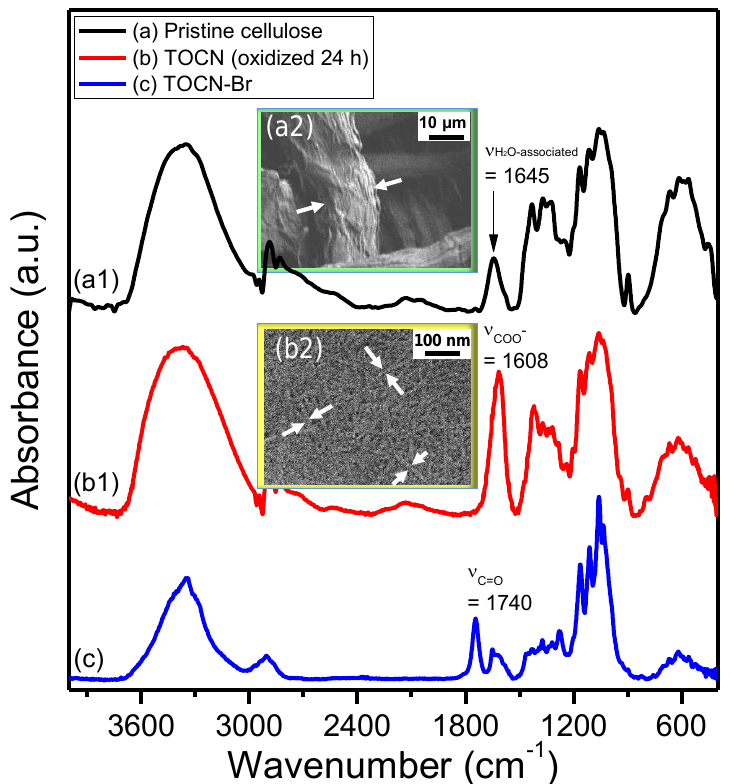
Figure 1. Fourier transform infrared (FT–IR) spectra (4000–400 cm − 1 ) and scanning electron microscopy (SEM) images (inserted) of ( a ) pristine cellulose, ( b ) TEMPO-oxidized cellulose nanofibers (TOCN), and ( c ) TOCN–Br.